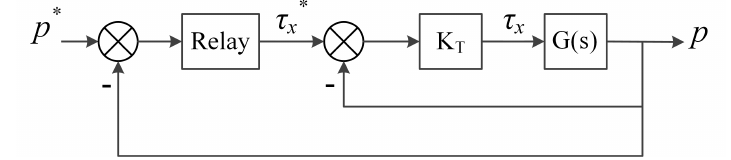
Figure 4. Relay feedback experiment for roll